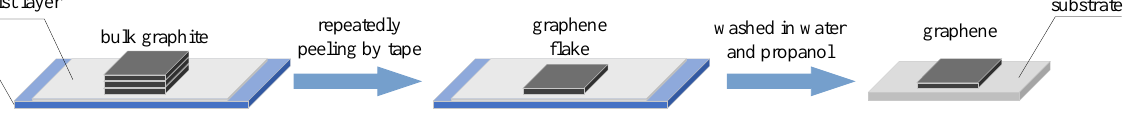
Figure 3. The preparation of a 2D material based on the ME